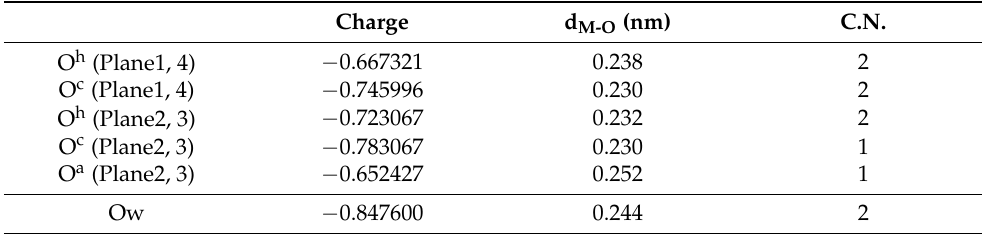
Table 1. The atomic RESP (restrained electrostatic potential) charges of O h and O c in t -HOPO 4 − , O a in the amide group and O w in the SPCE model; the distances (nm) of U-O h , U-O c and U-O w ; and the coordination number (C.N.) of U 4+ contributed by each type of ligating atoms. The data were calculated from 100 ns MD simulations.